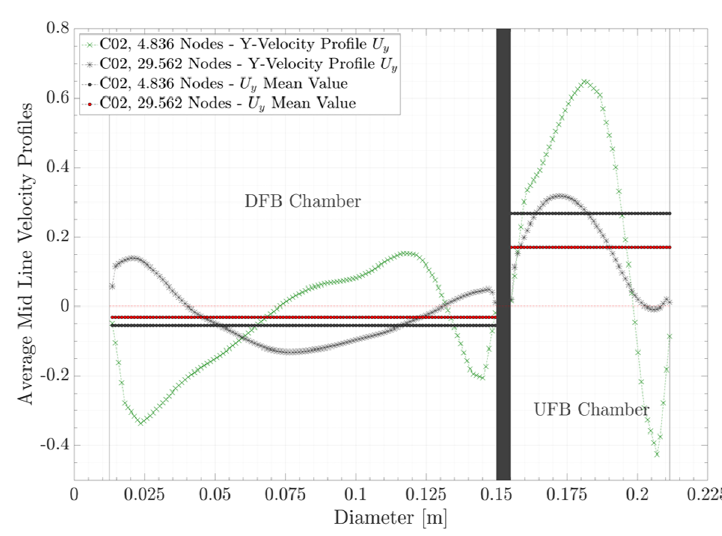
Figure 10. Main CFD results. Comparison between solutions obtained considering the coarsest and finest mesh: solid phase velocity profiles. Plotted data were averaged over simulation time between 1 s and 20 s.